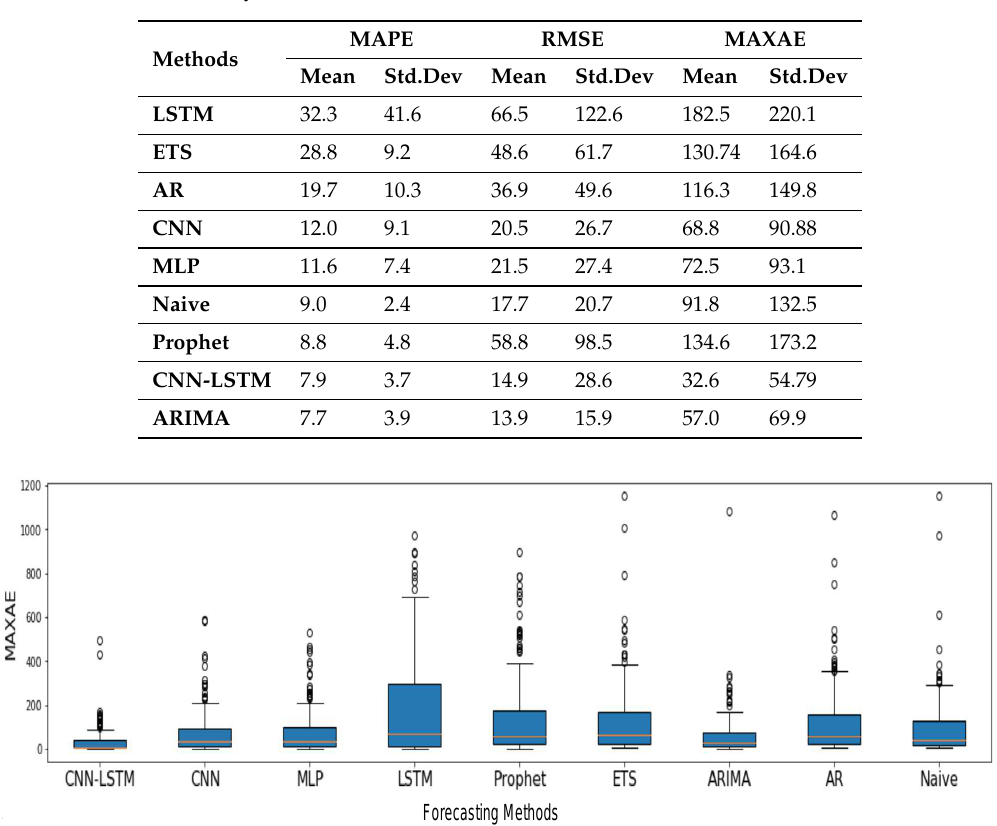
Table 1. Mean and standard deviation for each of the three performance measures across all the considered cells sorted by MAPE error.